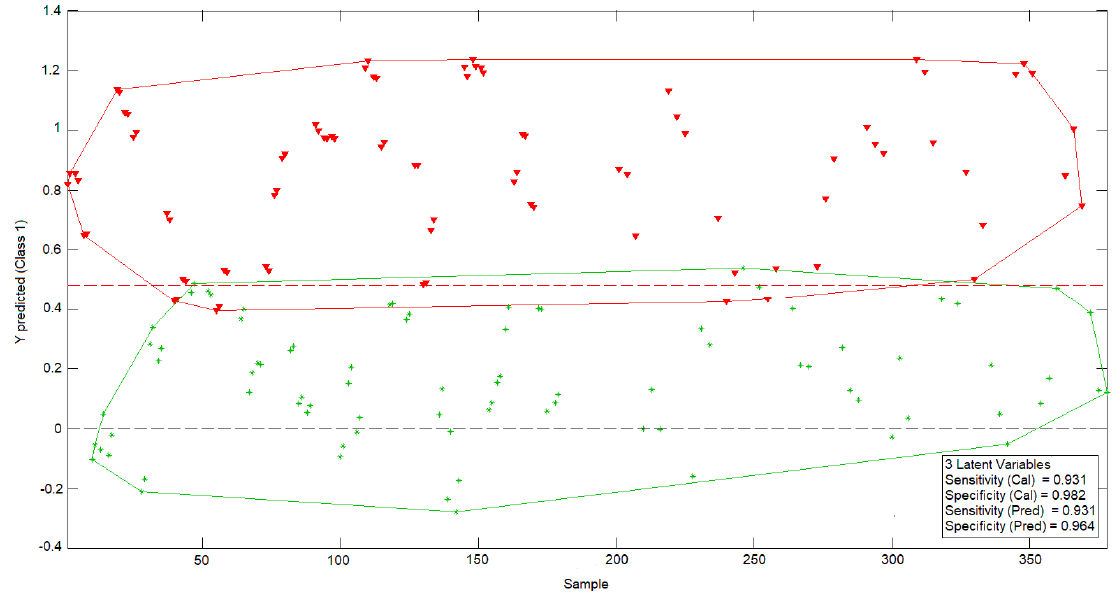
Figure 6. Partial least squares discriminant analysis (PLS-DA) analysis for the same data set. Class 0 (red): Frozen samples. Class 1 (green): Natural samples.